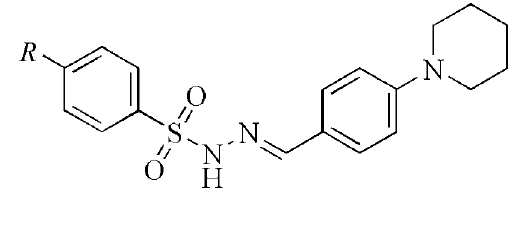
Figure 2 Molecular structure of (II), showing the atom labelling and displacement ellipsoids drawn at the 50% probability level.